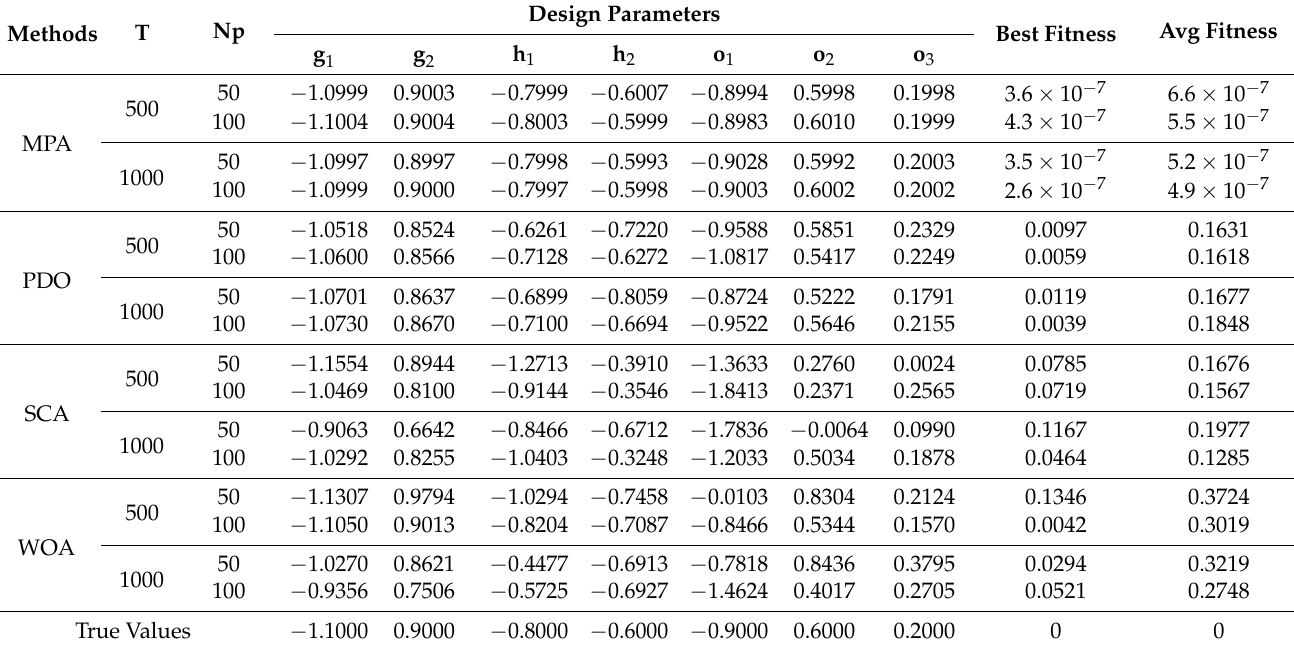
Table 2. Estimated weight analysis w.r.t generation and population sizes at 60 dB noise for case study 1.